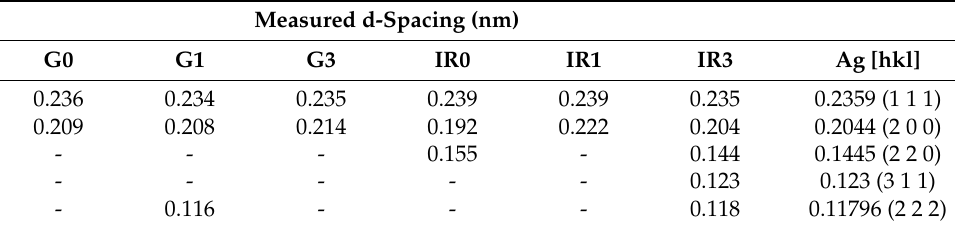
Table 2. The d-spacing as measured from selected area electron diffraction (SAED) performed on Ag nanoparticles obtained by (G0), (IR0) laser ablation, (G1), (IR1) by one re-irradiation, (G3), (IR3) by three re-irradiations, using the Green-nanosecond laser and the IR-picosecond one, respectively, and compared to those of metallic Ag.